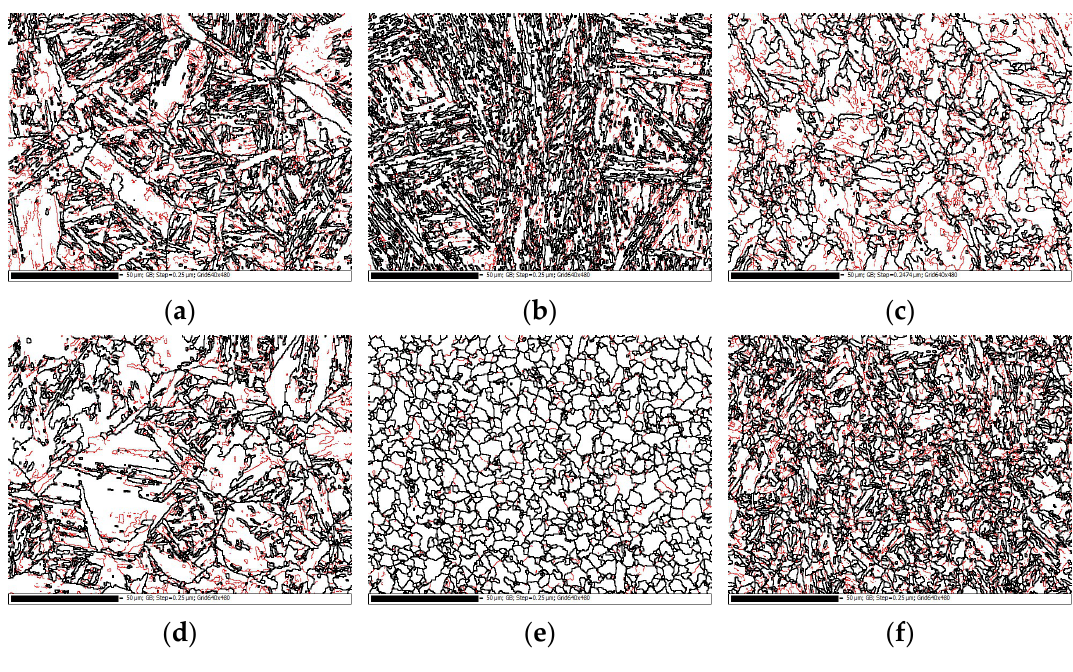
Figure 12. Distribution of HAGBs and LAGBs in the welding thermal simulation samples: ( a ) CGHAZ of 0 V; ( b ) GRHAZ of 0 V; ( c ) ICHAZ of 0 V; ( d ) CGHAZ of 10 V; ( e ) GRHAZ of 10 V; and ( f ) ICHAZ of 10 V.